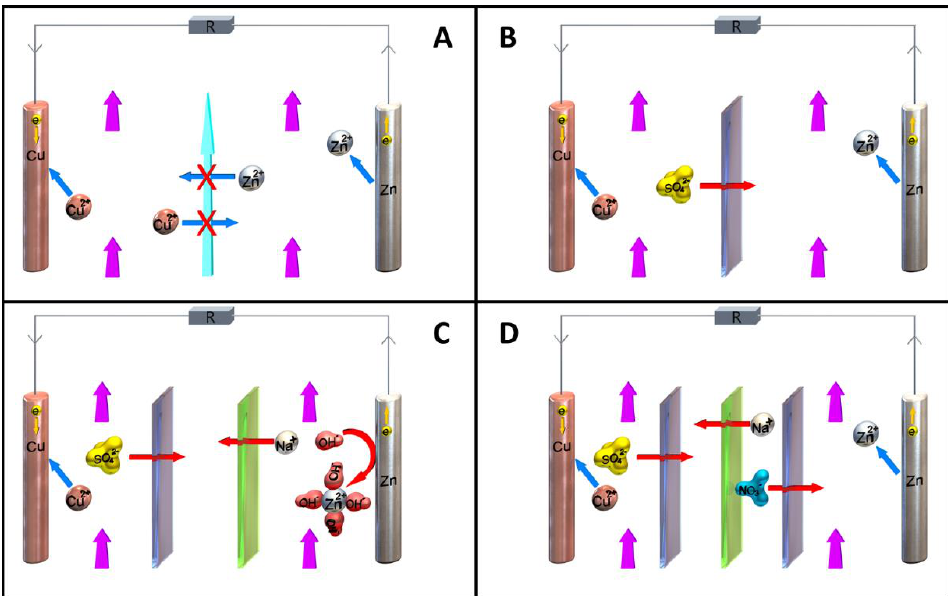
Figure 4. Different numbers of ion exchange membranes and their functionality explained on a D ANIELLE -cell-like model during discharge: ( A ) Setup with no membranes, realized by laminar flow, which prevents cross-stream diffusion, and therefore, intermixing of the anolyte and the catholyte. ( B ) Setup with one ion exchange membrane (here an anion exchange membrane (AEM)). This represents the most common setup. ( C ) Setup with two membranes. One AEM und one CEM. This setup is used when the electrolyte compositions of the anolyte and catholyte are different and the non-redox active counter-ions each have opposite charges. ( D ) Setup with three membranes with a symmetrical membrane arrangement (either AEM/CEM/AEM or CEM/AEM/CEM). This setup is used to highly suppress crossover of the RAS.